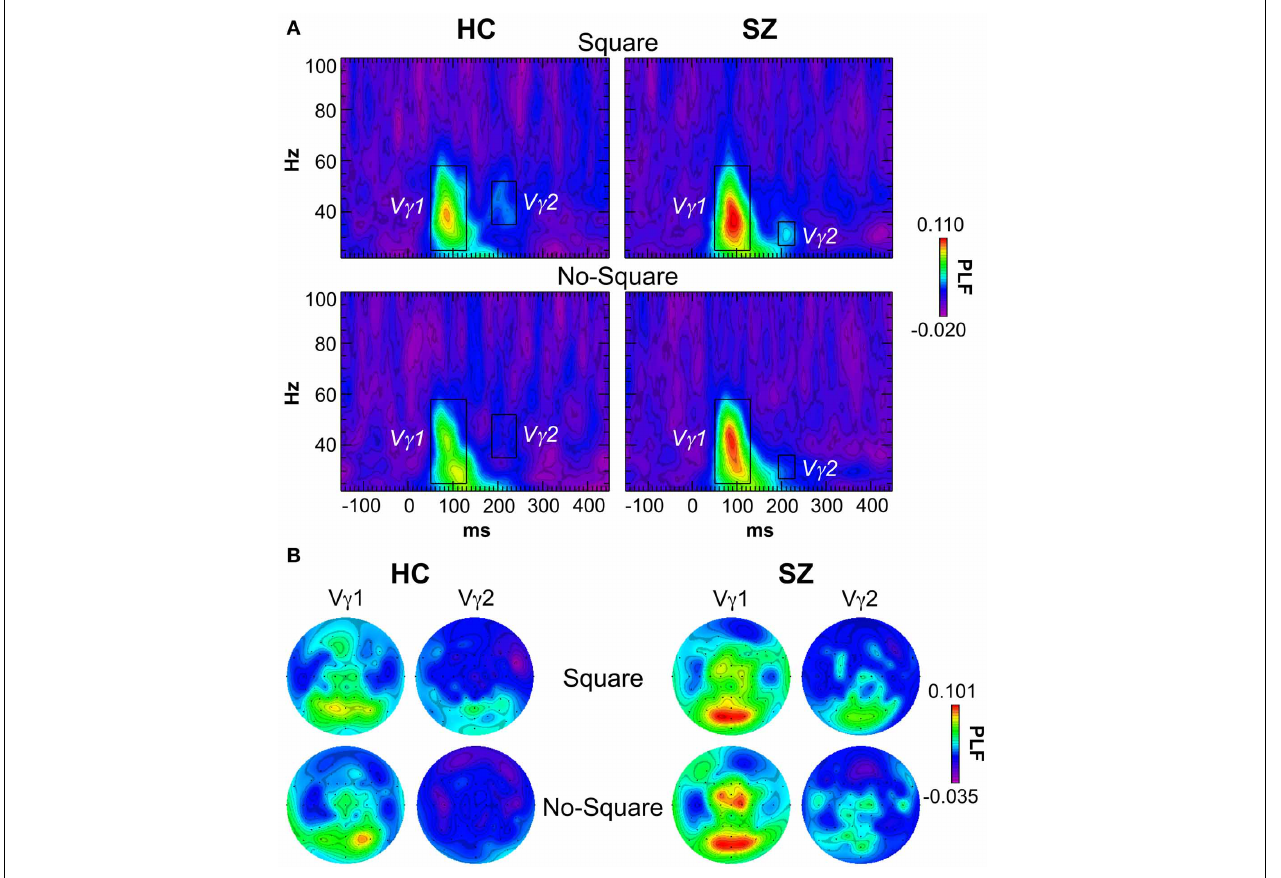
FIGURE 3 | Stimulus-locked time-frequency (TF) maps of phase-locking factor (PLF). (A) TF maps averaged across the posterior electrodes in the Square and No-Square conditions for each group. The TF windows within which the V γ 1 and V γ 2 oscillations